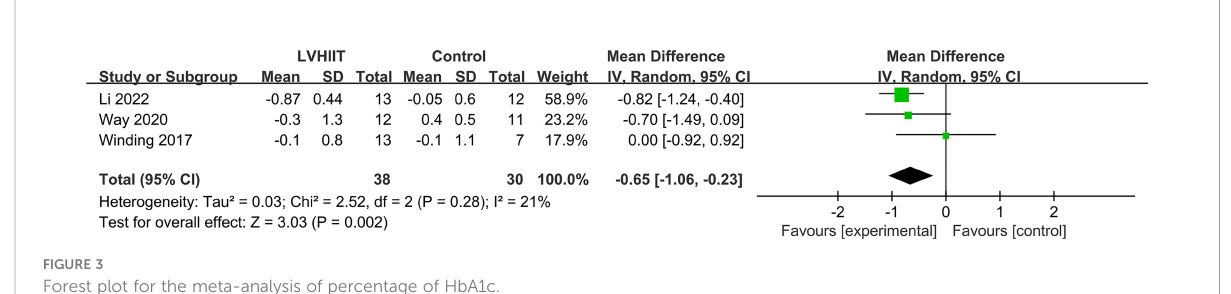
FIGURE 3 Forest plot for the meta-analysis of percentage of HbA1c.